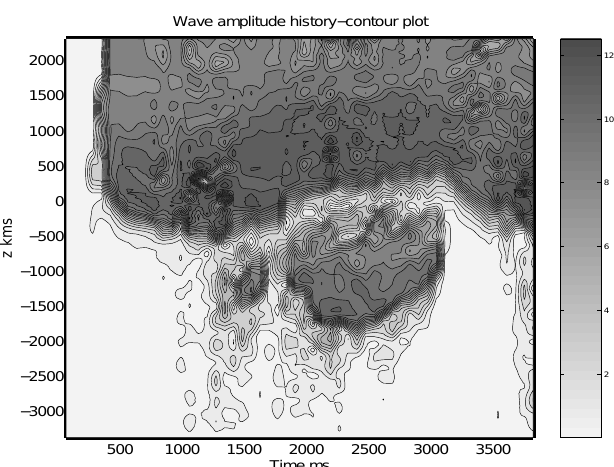
Fig. 18. Run 3. Wave amplitude (pT) history of the simulation. The central region from t = 1 . 5s to t = 3 . 0s corresponds to a faller GR, which extends further upstream into the positive inhomogene- ity region. Note the consistent amplitude trough in the vicinity of the equator at z ∼ − 500km. This is a region of damping which occurs when the phase trapping angle moves between quadrants.